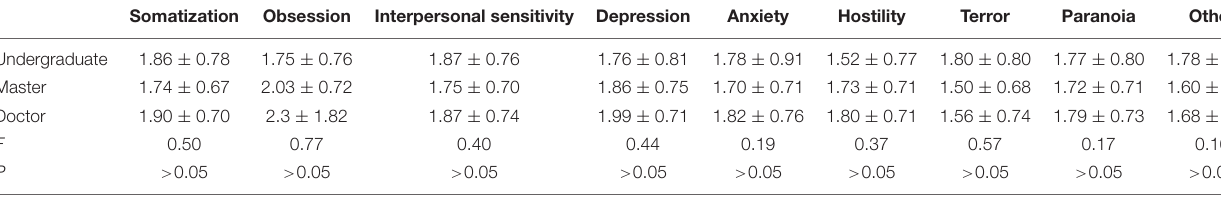
TABLE 4 | Comparison of survey results of teachers with different educational backgrounds. Somatization Obsession Interpersonal sensitivity Depression Anxiety Hostility Terror Paranoia Other